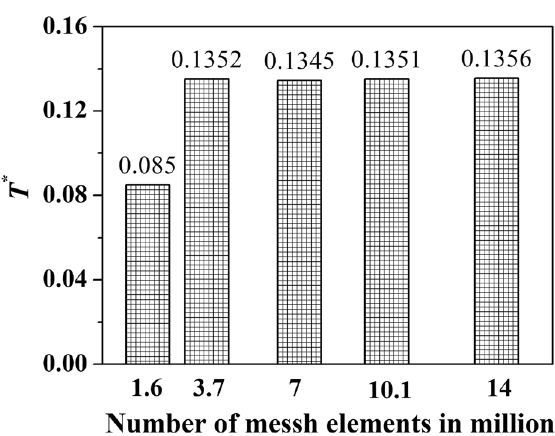
Figure 6. Variation of torque coefficient with grid numbers at φ =